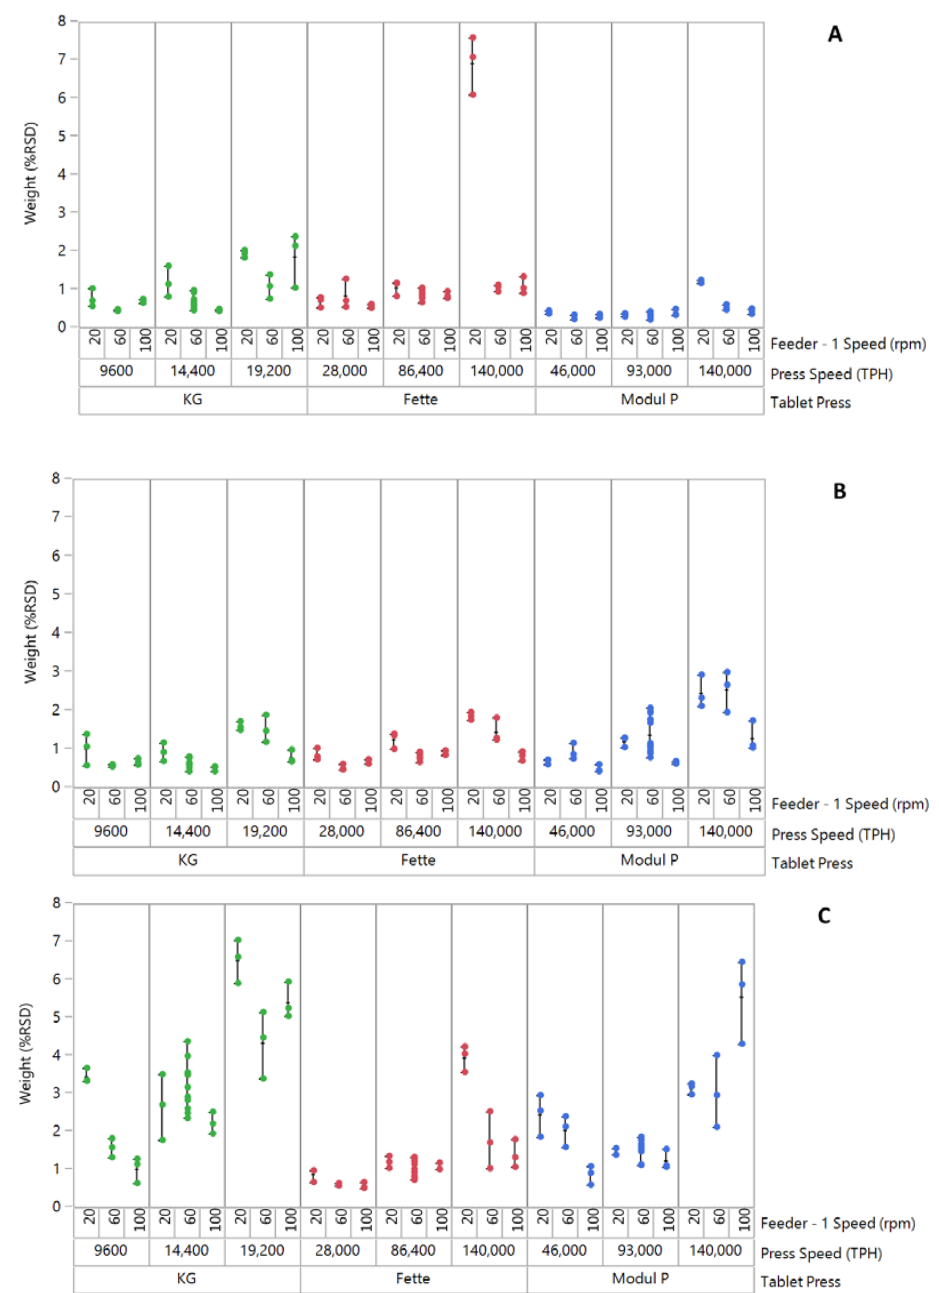
Figure 1. Plot of tablet weight variability (%RSD) for three formulations compacted on three tablet presses. ( A ) Good-flow formulation, ( B ) Medium/fair-flow formulation and ( C ) Passable-flow formulation. Each point on the graph signifies % RSD for n = 20 tablets. Approximately 12,000 tablets were compacted for individual runs in a DoE. A total of three in-process checks (IPCs) were per- formed for 20 tablets after every 4000 tablets compacted, within an individual DoE run. Data point for good flow formulation on Fette 1200i at 20 rpm feeder speed/140,000 TPH press speed was ex- cluded in process model development.